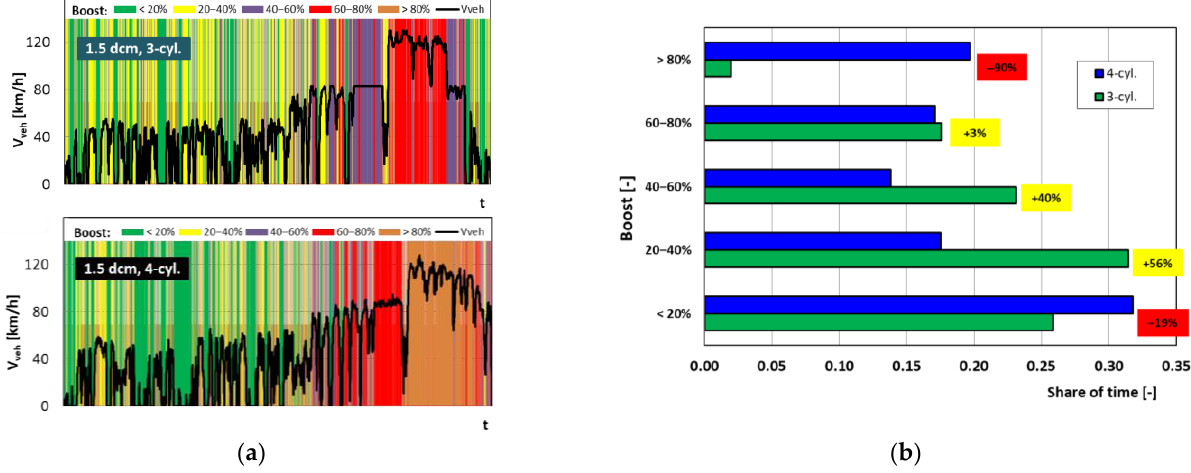
Figure 3. Analysis of the voltage boost depending on the instantaneous route profile: ( a ) conditions for boost in both powertrain generations; ( b ) analysis of changes of the boost usage.